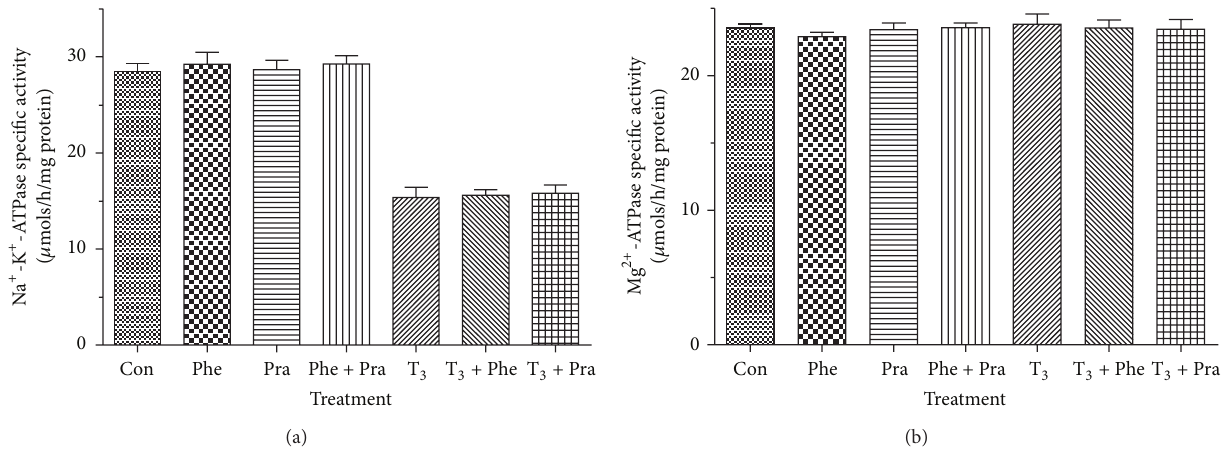
Figure 4: Modulation of the T 3 action on synaptosomal Na + -K + -ATPase activity by a selective 𝛼 1 -adrenergic agonist (PHE) and a selective 𝛼 1 -antagonist (PRA) in vitro . A half-maximally effective dose of T 3 (1nM) was chosen from the dose-response curve for T 3 in Figure 1. The doses for PHE and PRA used for the in vitro experiment were 1nM in each case. The data are represented as mean ± SEM of five separate experiments, taking six animals in each group. The vertical lines denote